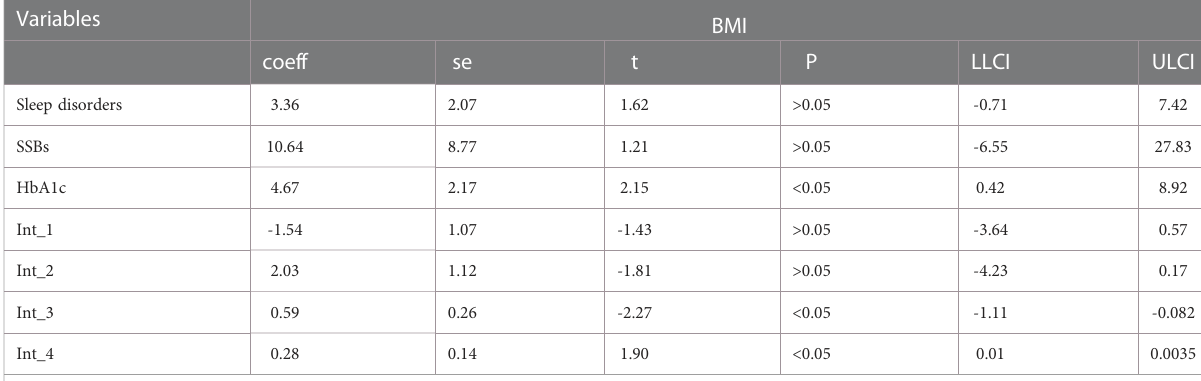
TABLE 6 The moderation analysis between SSBs, Sleep disorders, HbA1c and BMI. Variables